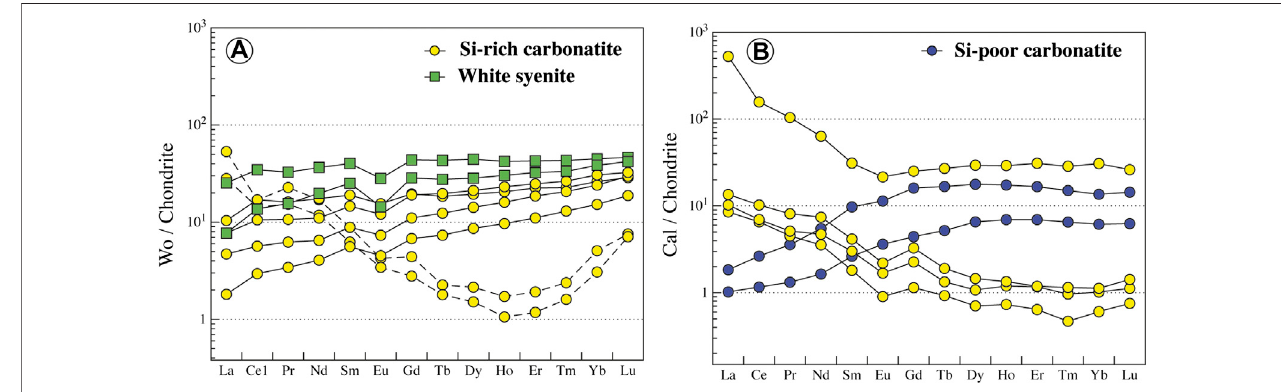
FIGURE11| NormalizedREEcontentofwollastoniteandcalcitefromIhouhaouenecarbonatitesandassociatedsilicaterocks.Chondritevaluesareobtainedfrom Taylor and McLennan (1985). Altered wollastonite is shown in dashed